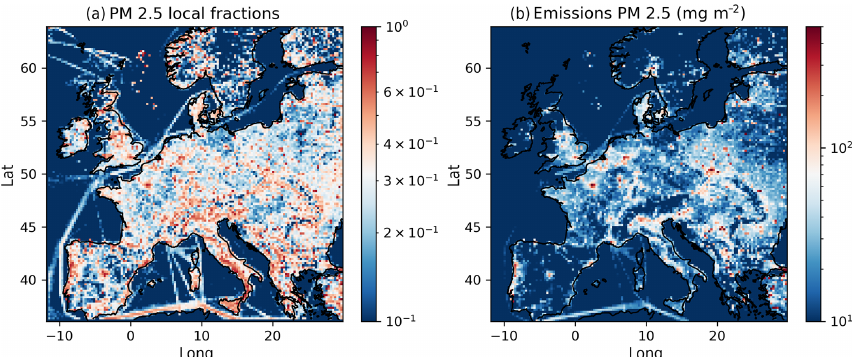
Figure 2. Example of the spatial distribution of the local fraction of PM 2 . 5 averaged over 1 month (March 2016, a ). The total emissions of PM 2 . 5 accumulated over that period are shown in (b) .